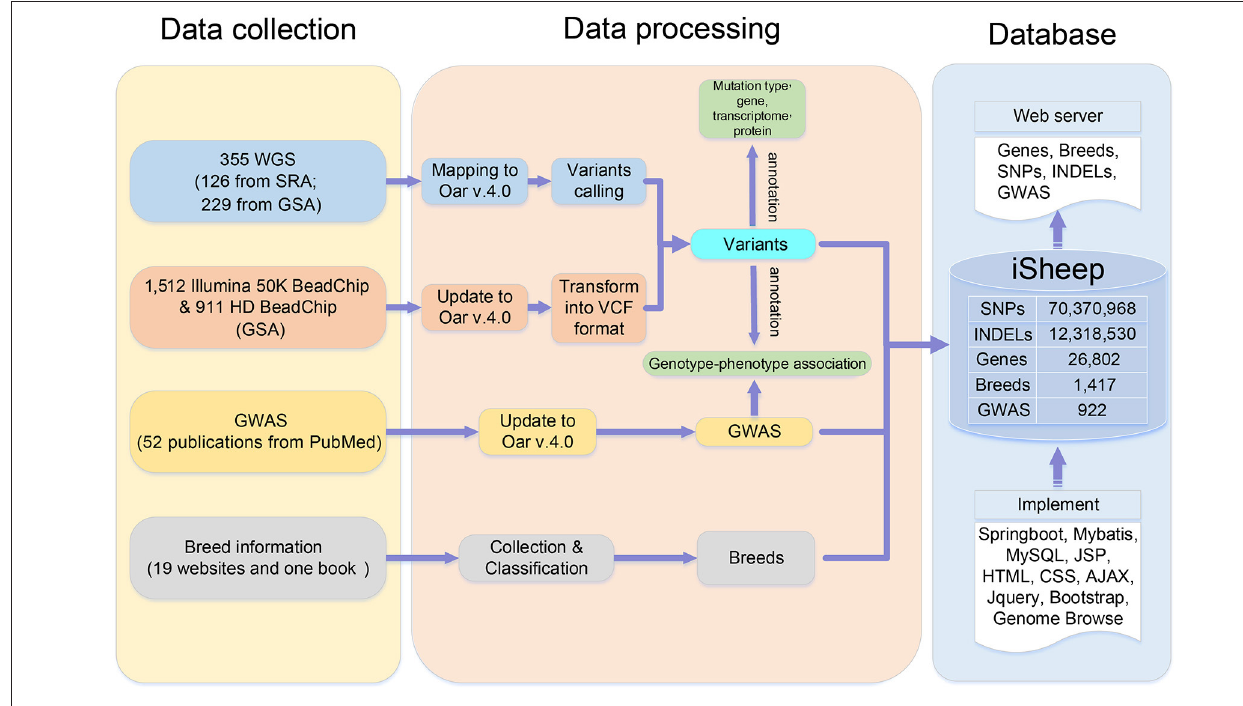
FIGURE 1 | Data sources and pipelines of iSheep.